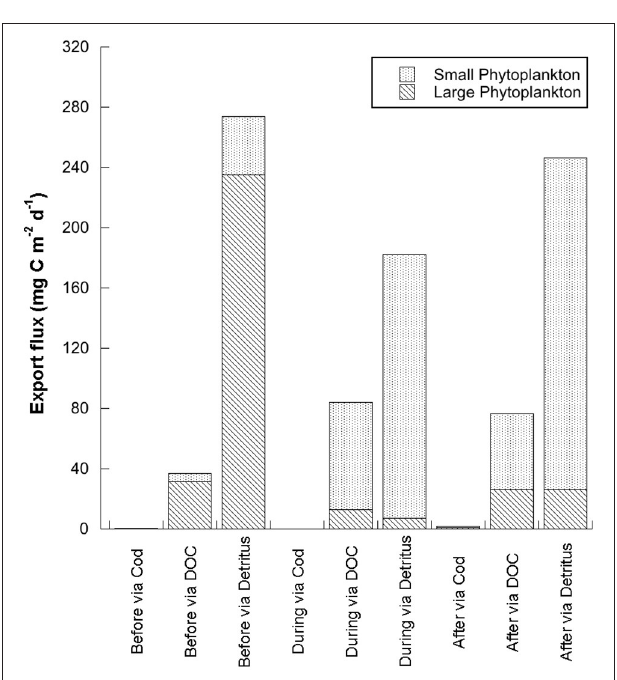
FIGURE 5 | Pathways of small (including Phaeocystis sp .) and large (diatom) phytoplankton carbon export: via cod, via dissolved organic carbon (DOC) and via particulate organic carbon (POC) or